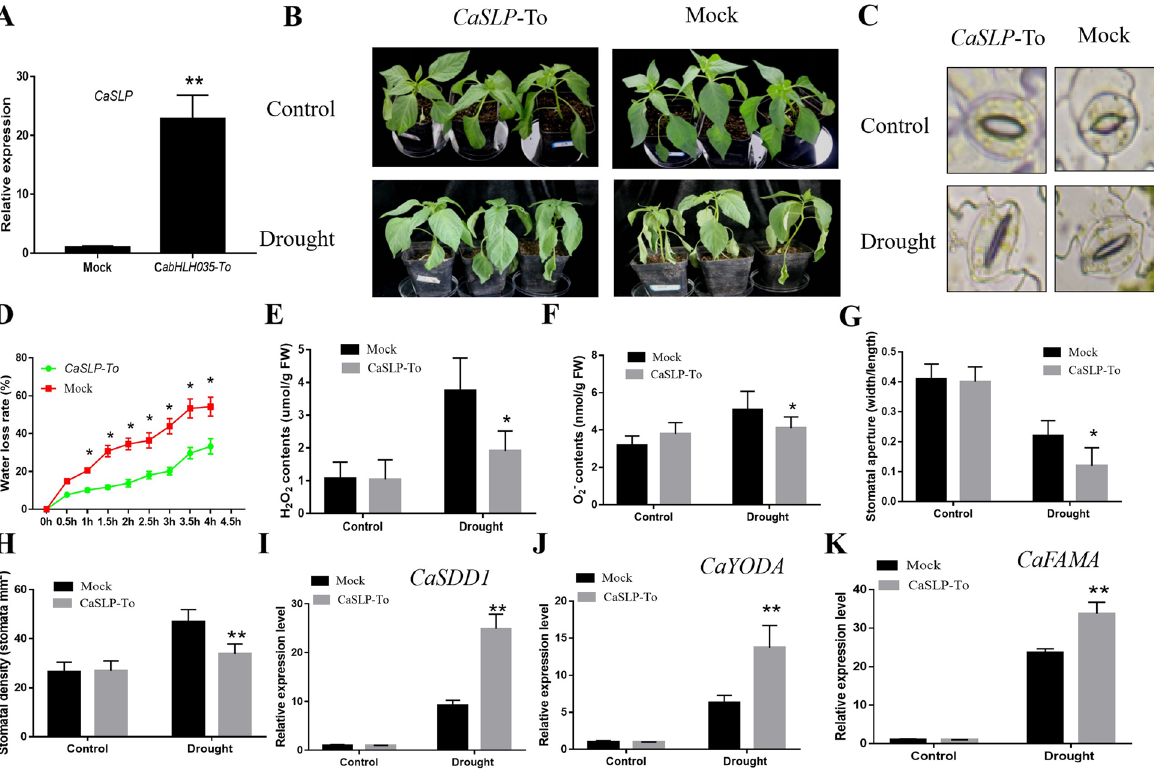
Fig. 3 Transient expression of CaSLP significantly improved pepper drought tolerance. A The transcript levels of CaSLP. B Phenotype of CaSLP -To (Transient overexpression) and the control (35S::GFP) plants before and after 48 h of drought treatment. Plants were treated under water deficit conditions for 48 h. C - G Stomatal aperture ( C ), Water loss rate ( D ), H 2 O 2 content ( E ), O 2 . . − content ( F ), Contents of CaSLP -To and the control plants before and after 48 h of drought treatment. G Stomatal aperture. H Stomatal density. I - K Transcript levels of the stomatal development genes SDD1 ( H ), YODA ( I ), and FAMA ( J ) were measured by qRT-PCR in CaSLP -To and the control plants before and after the drought treatment. Values are means SD ( n 3). Different asterisks represent significant differences (*, P < 0.05; **, P < ± =